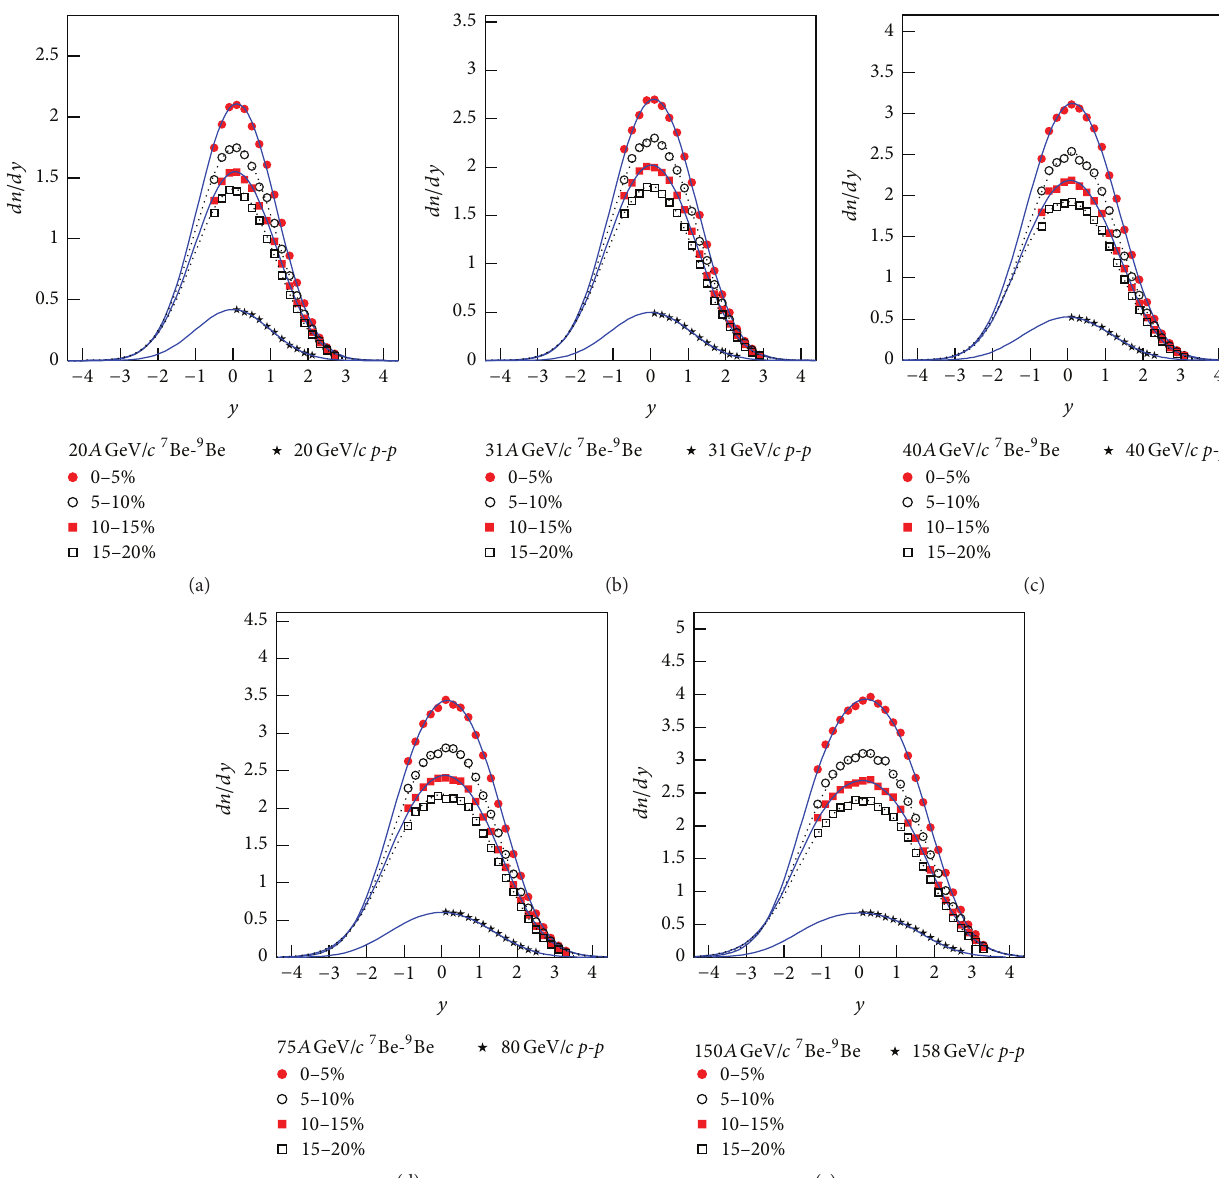
Figure 1: Rapidity distributions of negatively charged pions produced in 𝑝 - 𝑝 and 7 Be- 9 Be collisions at the SPS. (a)–(e) Corresponding to different beam momentums marked in the panels. The symbols represent the experimental data of the NA61/SHINE Collaboration [6, 7] and the curves are our results fitted by the revised (three-source) Landau hydrodynamic